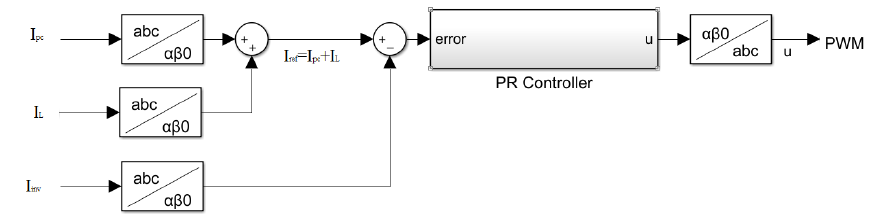
Figure 3. The proposed current control method using PR